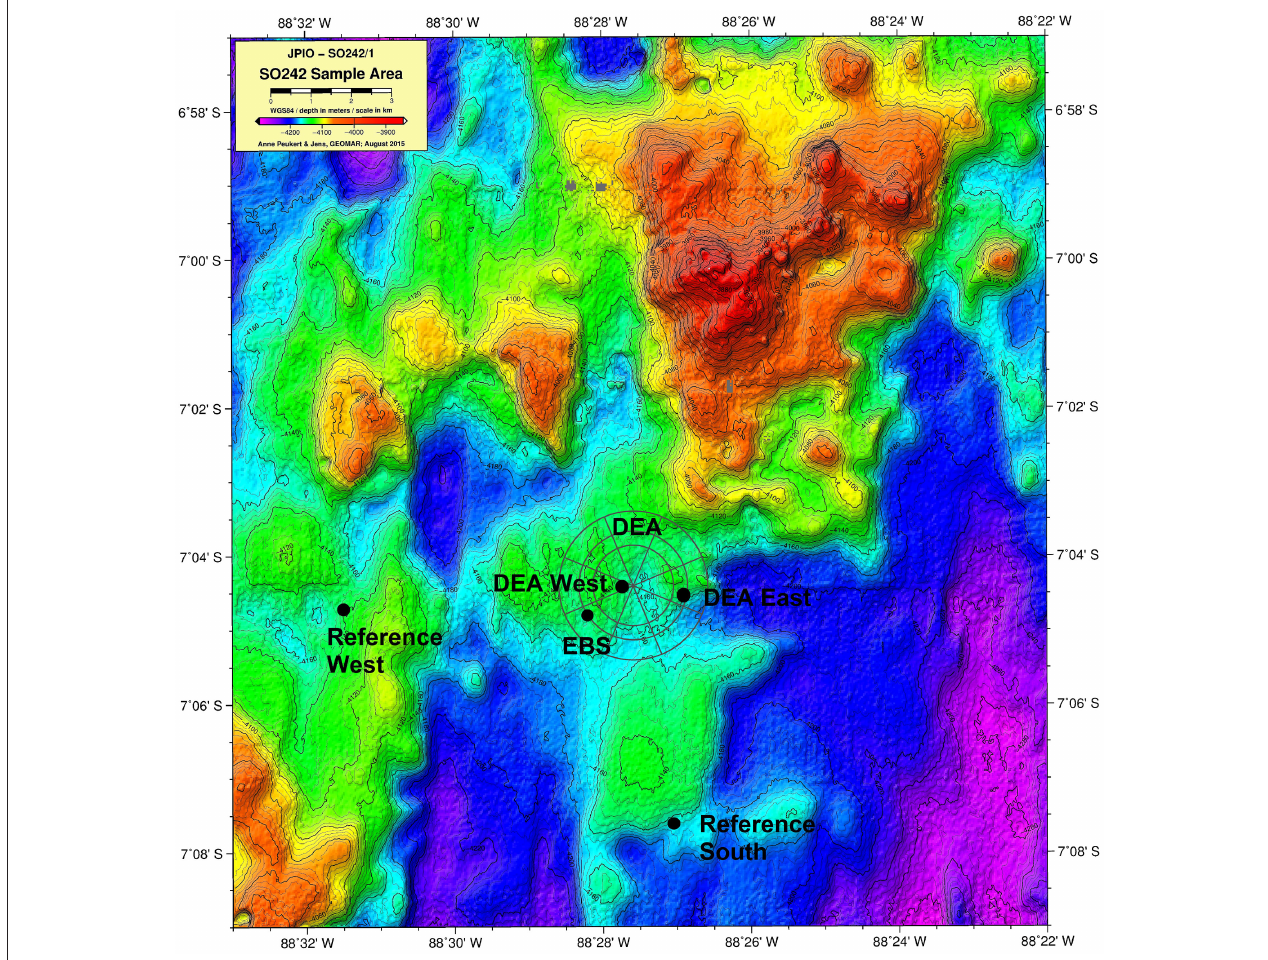
FIGURE 1 | Sampling sites of sediment cores in the DISCOL area (adapted from a map by Anne Peukert, GEOMAR, working group of Jens Greinert). The circle indicates the DISCOL experimental area (DEA) in which the disturbance experiment had been carried out in